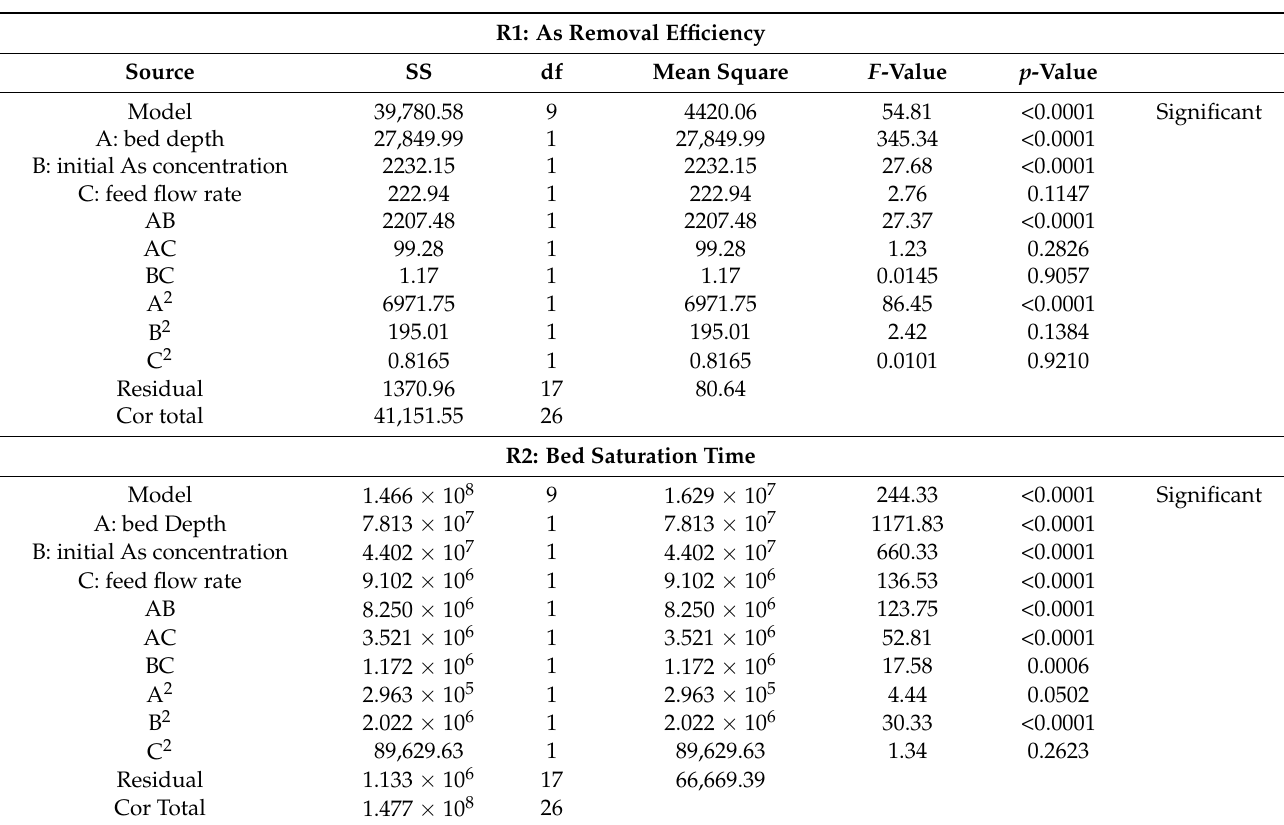
Table 5. ANOVA results for response surface quadratic model responses, R1: As removal efficiency; R2: bed saturation